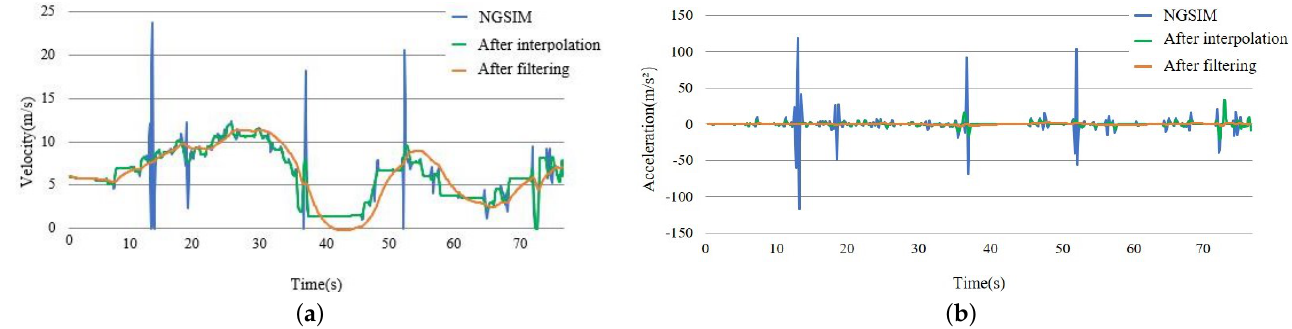
Figure 3. Comparison before and after data preprocessing: ( a ) instantaneous velocity comparison of No. 1882 vehicle in I-80 and ( b ) instantaneous acceleration comparison of No. 1882 vehicle in